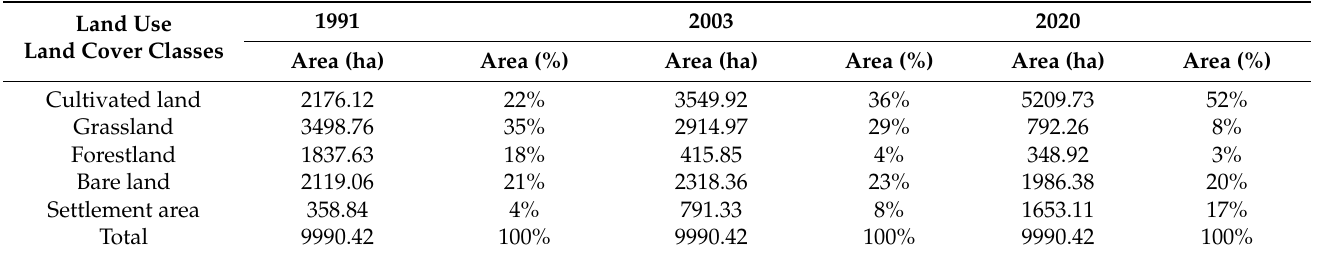
Table 4. Land use land cover (LULC) classification of Matenchose watershed 1991, 2003, and